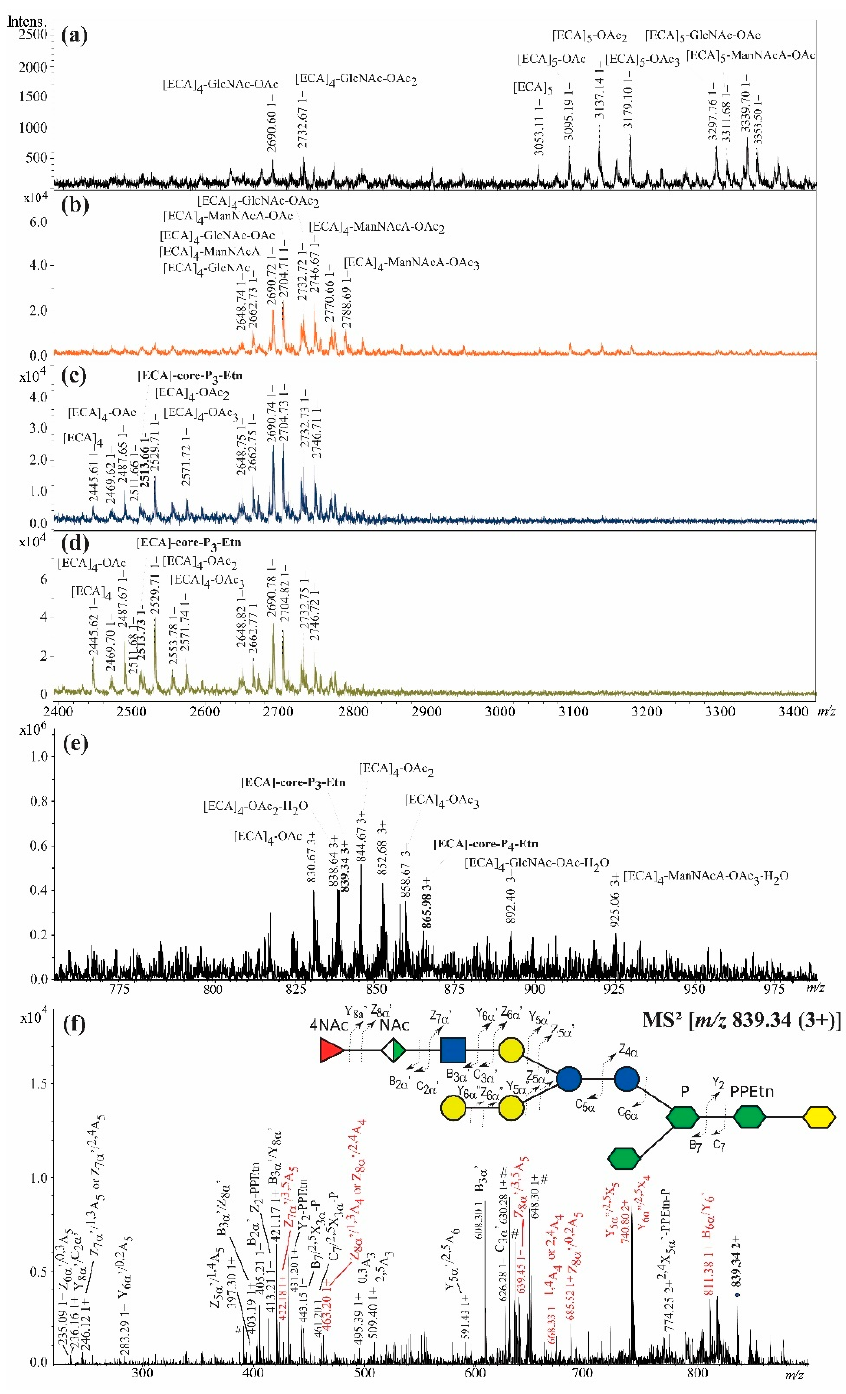
Figure 5. The mass spectra of ECA-containing fractions isolated from E. coli R4 LOS preparation. ( a ) The matrix-assisted laser desorption/ionization-time of flight (MALDI-TOF) negative-ion mode MS of the fraction 25; ( b ) the negative-ion mode MALDI-TOF MS of the fraction 26; ( c ) the negative-ion mode MS of the fraction 27; ( d ) the negative-ion mode MALDI-TOF MS of fraction 28; ( e ) the positive-ion mode ESI-MS spectrum of the fraction 28; ( f ) the ESI-MS 2 spectrum of the ion at m/z 839.34 (3+) attributed to [ECA]-core-P 3 -Etn glycoform, where core stands for [ECA]-Gal 3 -Glc 2 -Hep 3 -Kdo oligosaccharide. The interpretation of ions is shown in Table 4. The most informative ions are colored in red. The mark # stands for non-interpreted ions. The fraction 25 was identified as linear polymers of ECA repeating units derived most probably from in-source fragmentation of ECA PG and devoid of PG moiety and built up of [ECA] 4 and [ECA] 5